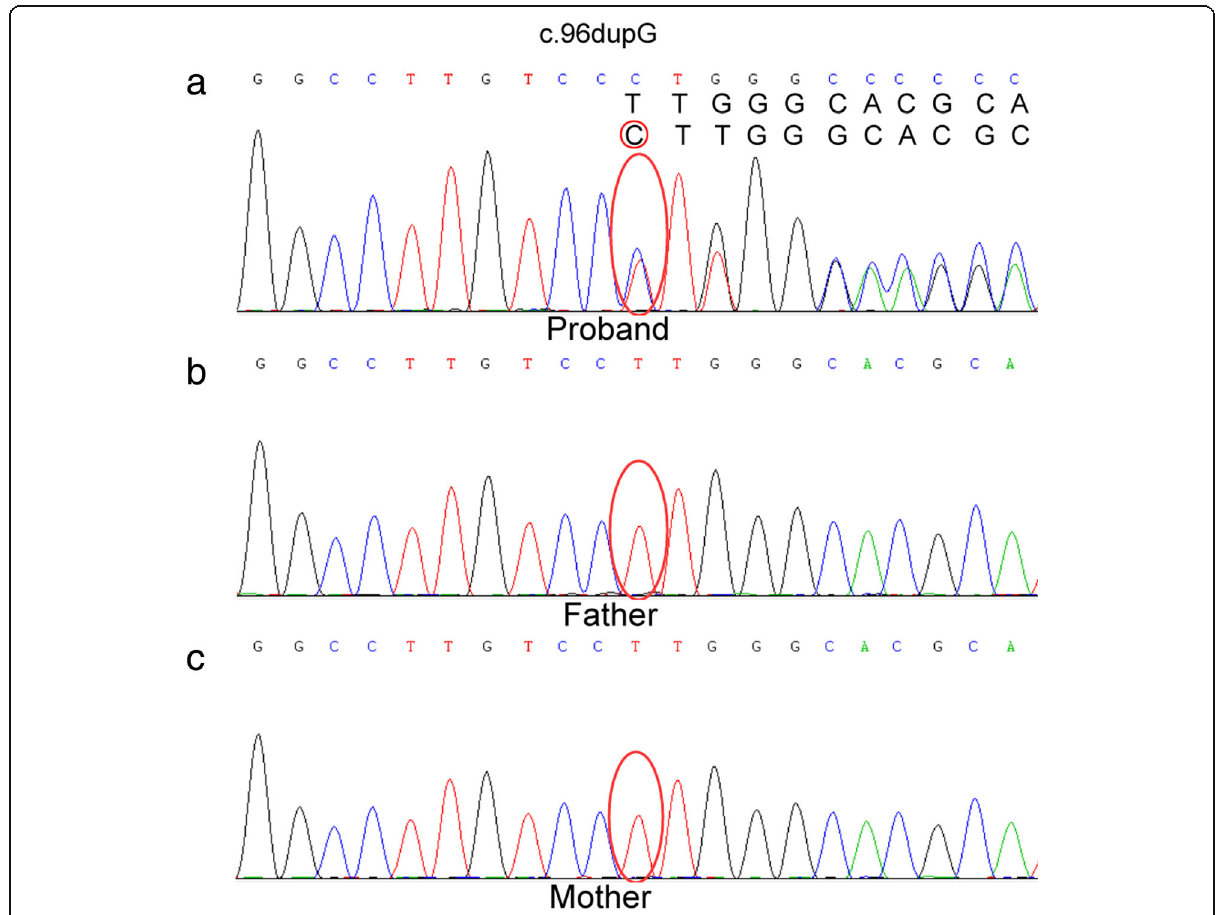
Fig. 1 Sanger traces for PCR products of the patient and his parents. a Sanger traces for PCR products of the patient indicated a heterozygous insert mutation in RPS26 (c.96dupG). Cytosine is the complementary base of Guanine. b , c Sanger traces for PCR of his parents ( b for the proband ’ s father, c for the proband ’ s mother), neither of his parents carry this